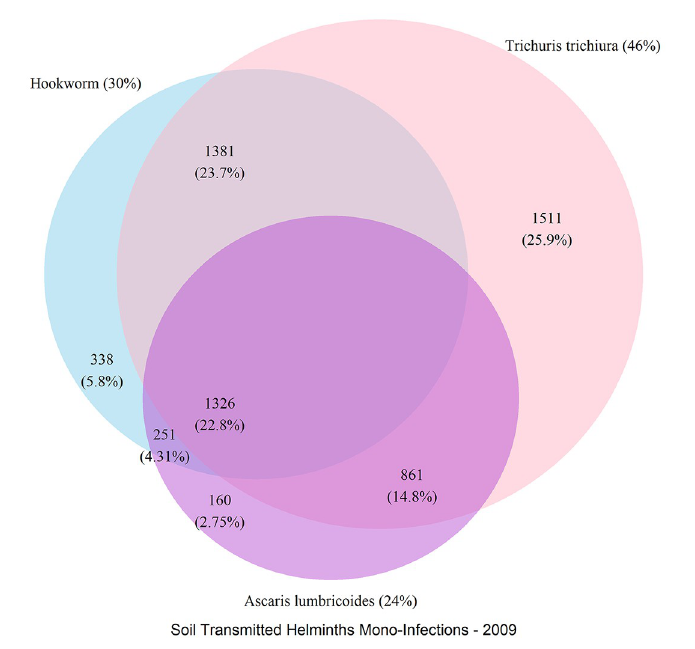
Fig 1. Venn diagram of single and multiple infections with Ascaris lumbricoides , Trichuris trichiura , and hookworm.